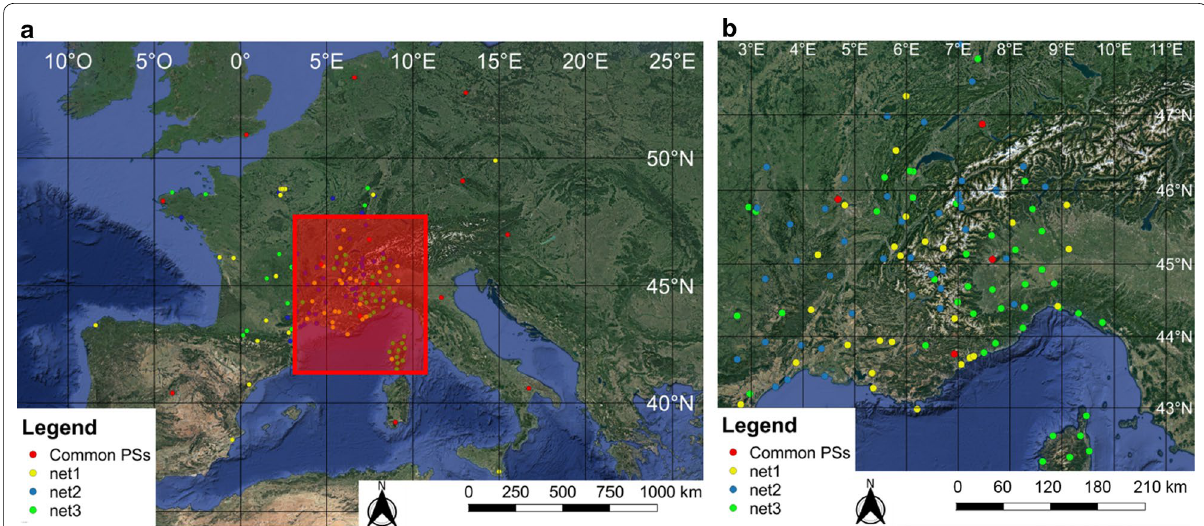
Fig. 1 Total extent of the GNSS network ( a ). The red rectangle corresponds to the French–Italian border region depicted in b in which the GNSS permanent stations (PSs) are denser. Common PSs are represented by red dots; net1, net2, and net3 are represented by yellow, blue, and green dots,